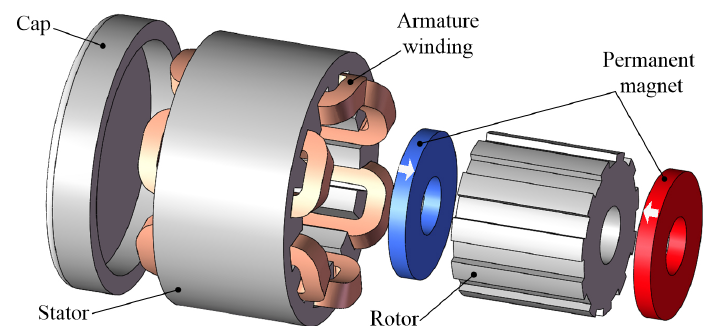
Figure 1. Structure of the axially magnetized VPM